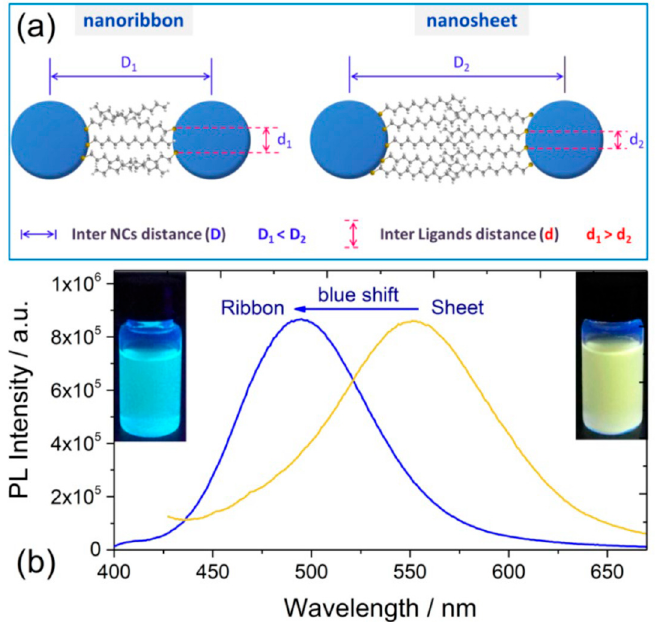
Figure 17. Ligand-assembly-mediated p band intermediate state (PBIS) dominates photoluminescence emission. Schematic illustration of the ligand exchange process and solvent-induced emission (SIE) properties of Au NCs (inset: the energy-level structure of Au NCs in water and ethanol mixed solution). The p band formed by the overlapping of p orbitals of electron-rich sulfur and oxygen heteroatoms of well-organized surface ligands is used as an intermediate state or dark state to tune the optoelectronic properties. Please see more details on the pioneering conceptual PBIS model. Reprinted with permission from Ref. [43]. Copyright (2019) Springer Nature.